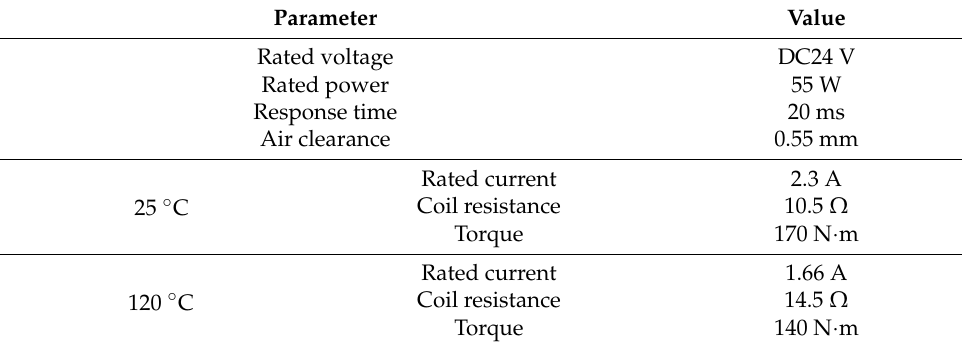
Table 4. Design requirements and brake parameters.